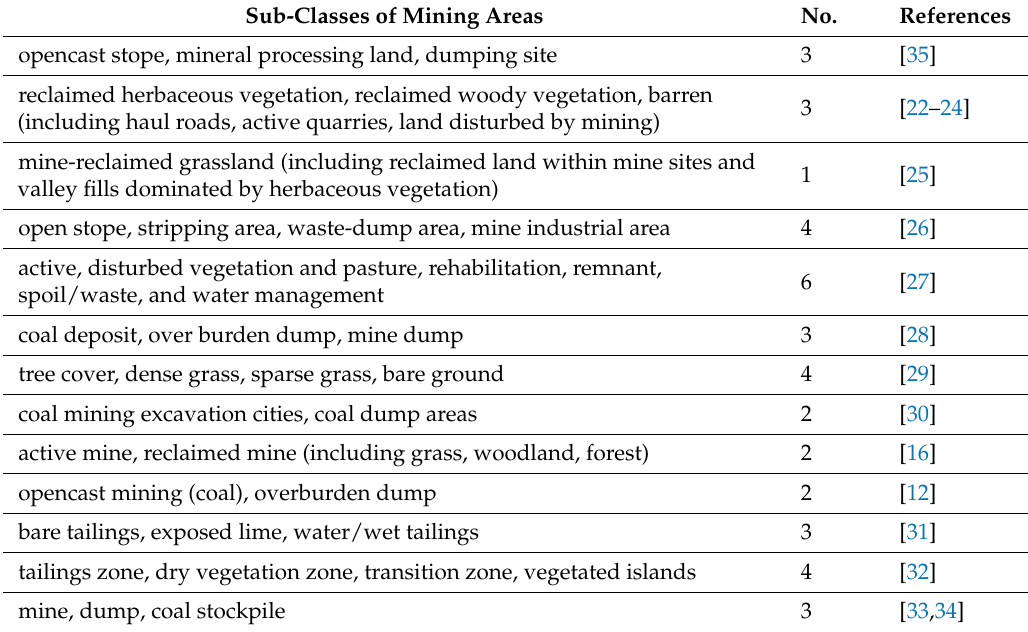
Table 1. Land cover sub-classes in mining